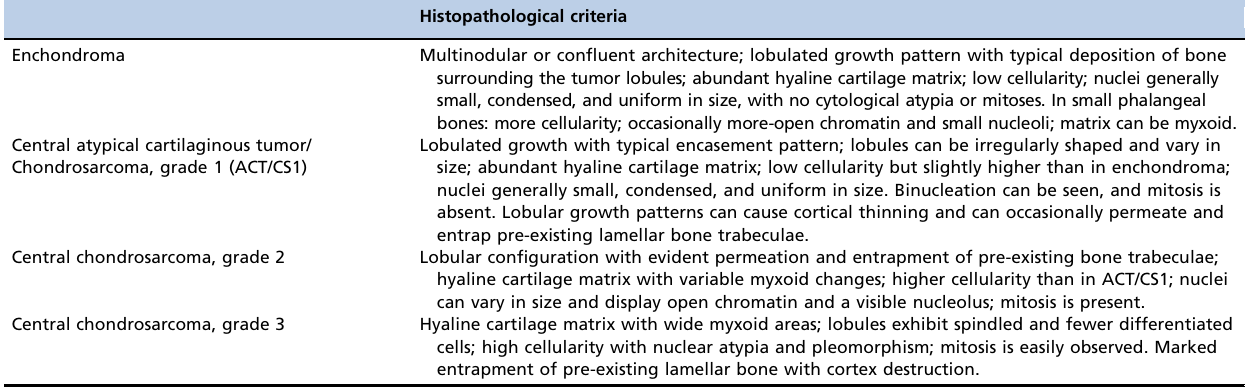
Table 1 - Histopathological criteria for enchondroma and central chondrosarcomas according to the World Health Organization Classification of Tumors of Soft Tissue and Bone, 2020. Histopathological